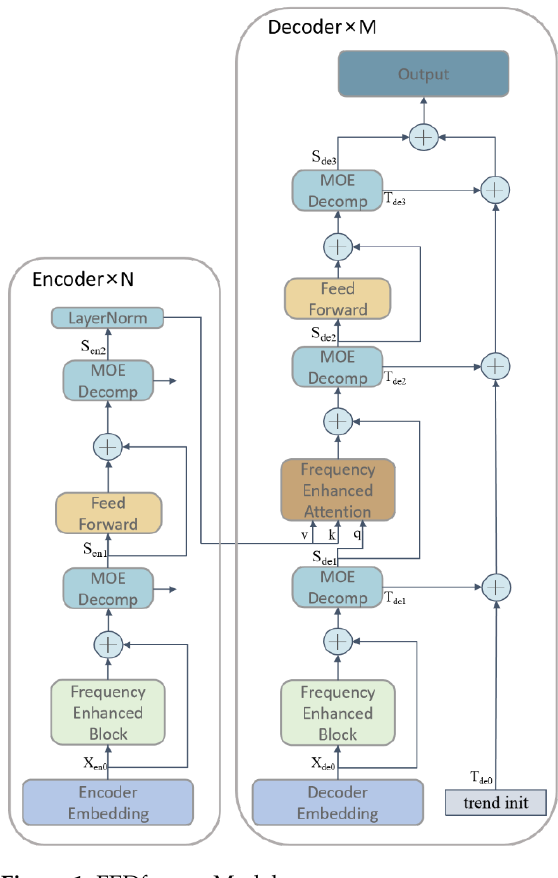
Figure 1. FEDformer